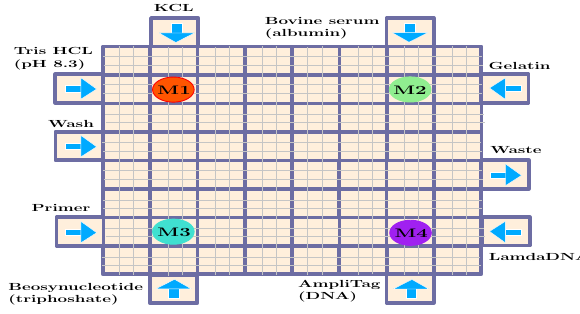
Fig. 12 Unique ASIC architecture for 𝟖 × 𝟖 PCR Bioassay